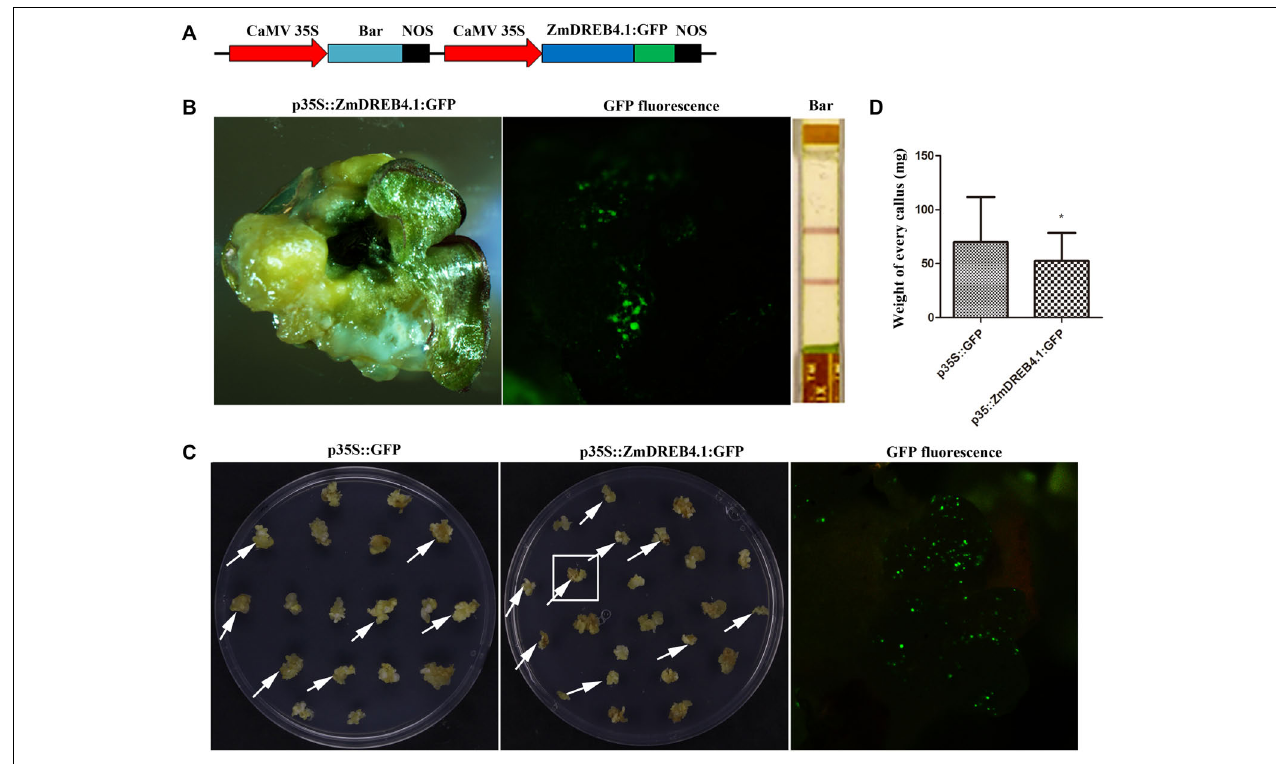
FIGURE 8 | ZmDREB4.1 repressed callus growth and regeneration in maize. (A) Diagram of ZmDREB4.1 overexpression vector. ZmDREB4.1 was fused to GFP and driven by CaMV 35S promoter. Bar gene was used as a selective marker. (B) The callus transformed with p35S::ZmDREB4.1:GFP. GFP fluorescence and bar protein expression were observed in this callus. However, this callus could not regenerate seedlings. (C) The calli with transient expression of p35S::ZmDREB4.1:GFP and p35S::GFP. The GFP fluorescence was observed in the callus which is indicated by a white pane. The arrows indicate positive calli. (D) The fresh weight of positive callus in (C) . The calli transformed with p35S::ZmDREB4.1:GFP were slightly lighter than those with p35S::GFP. The values represent the mean ± SD of the fresh weight from positive calli transformed with p35S::GFP and p35S::ZmDREB4.1:GFP vectors (for p35S::GFP, n = 34; for p35S::ZmDREB4.1:GFP, n = 32) and the statistically significant differences were evaluated by Student’s t -test ( ∗ P -value <